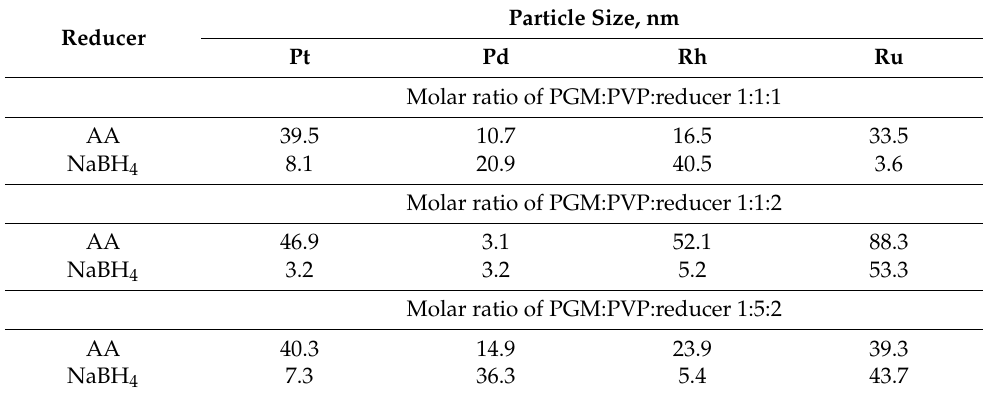
Table 2. Size of the precipitated particles obtained on the basis of the AFM (ambient temperature, pH 7–8).